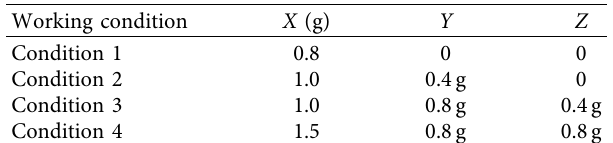
Figure 21: Maximum displacement response of pier roof under seismic waves at diferent sites. Table 3: Acceleration amplitude of input aqueduct structure in diferent working